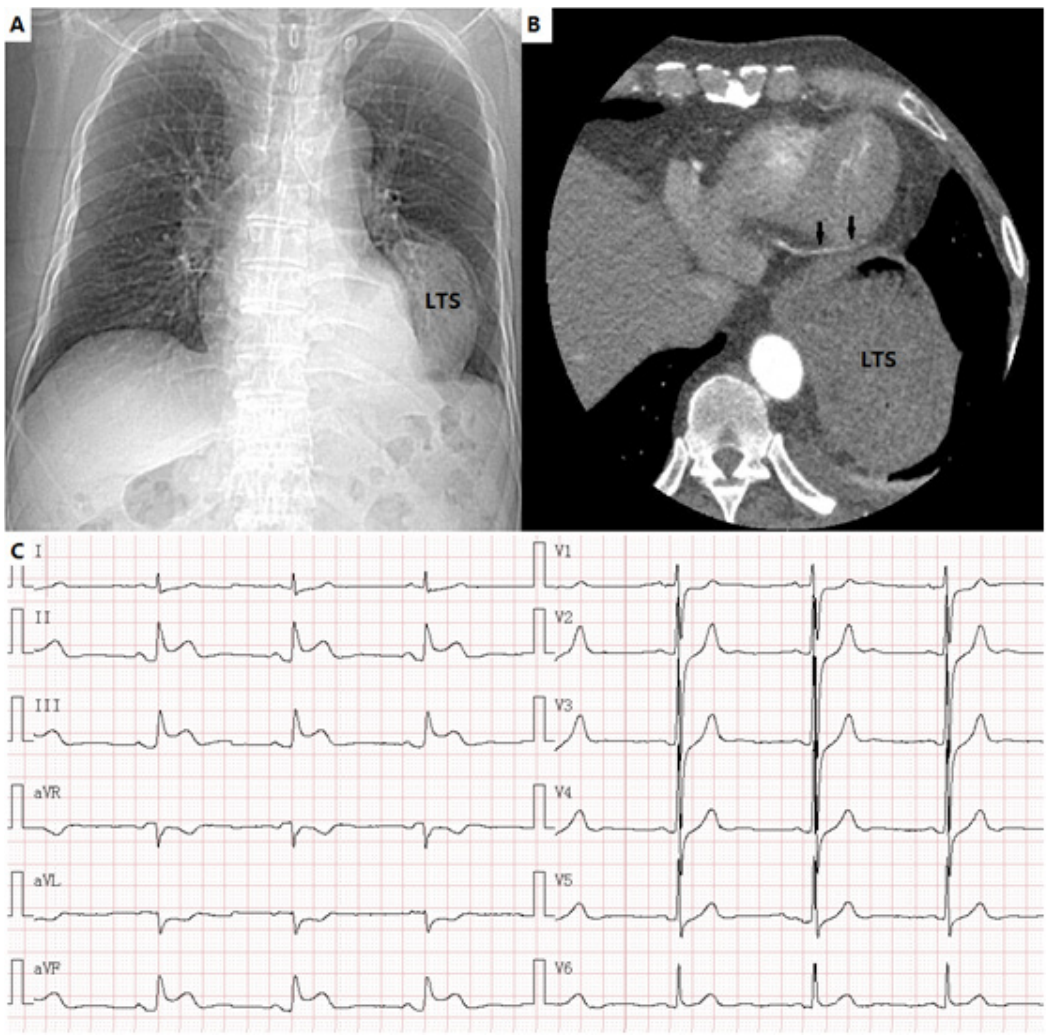
Fig. 1 – Images of chest radiography, computerized tomography angiography and ECG. A) Chest radiography revealed left thoracic stomach; LTS=left thoracic stomach; B) The distal right coronary artery coursed between the left ventricle and the thoracic stomach (arrows). C) Standard 12-lead ECG revealed sinus bradycardia with ST segment elevation in leads II, III and aVF and ST depression in leads I,